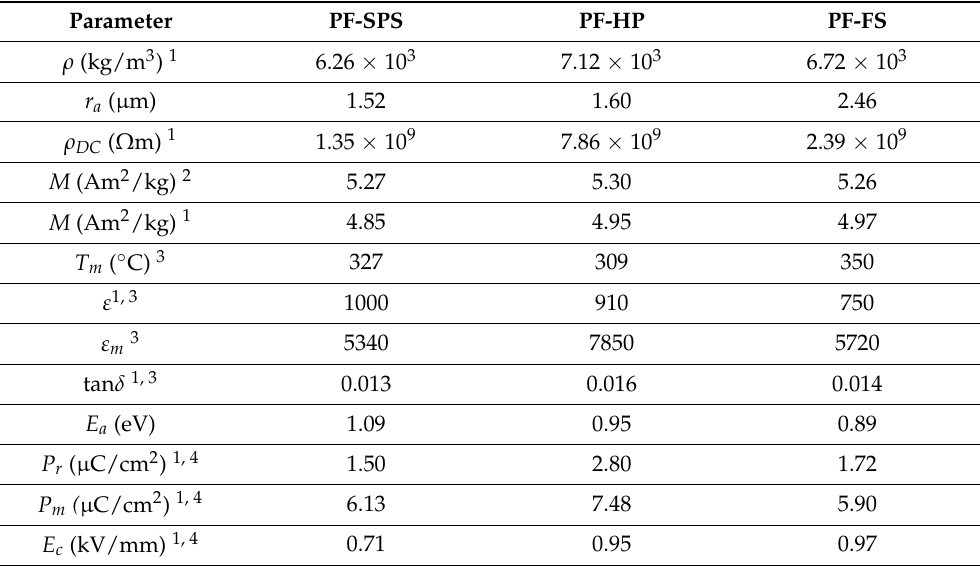
Figure 4. Grain size distribution of the magnetic grains in the ferroelectric composite matrix for the PF composites: PF-SPS ( a ), PF-HP ( b ), and PF-FS ( c ). Table 1. Parameters of the PF multiferroic